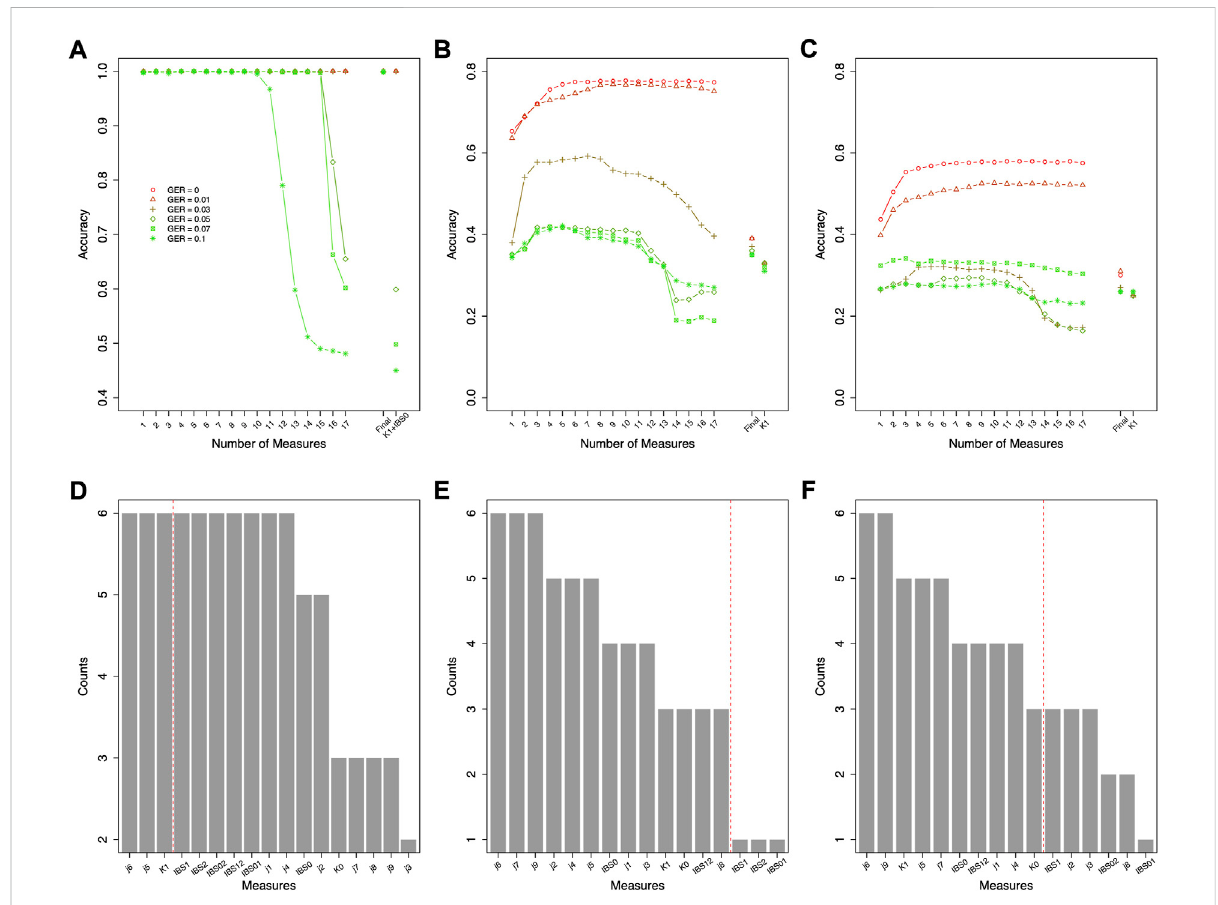
FIGURE 6 Forward feature selections and classi fi cation accuracies for relationship types using data simulated with various genotyping error rates. (A) the accuraciesforthe1stdegreerelationships, (B) theaccuraciesforthe2nddegreerelationships, (C) theaccuraciesforthe3rddegreerelationships, (D) thecountsoftheselectedfeaturesforthe1stdegreerelationshipsacrossallgenotypingerrors(e.g.,K1andK0wereselectedinthefeatureselections with all six genotyping errors), (E) the counts of the selected features for the 2nd degree relationships across all genotyping errors, and (F) the counts of the selected features for the 3rd degree relationships across all genotyping errors. The features on the left of the red dash line were selected as fi nal features. Final = classi fi cation with the fi nal features; GER = genotyping error rate of the test